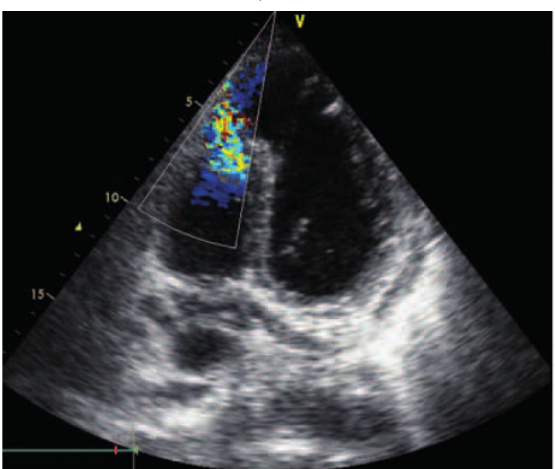
Figure 1. Four-chamber view on transthoracic echo – color Dop- pler showing left-to-right shunt in the apical segment of interventricular septum.